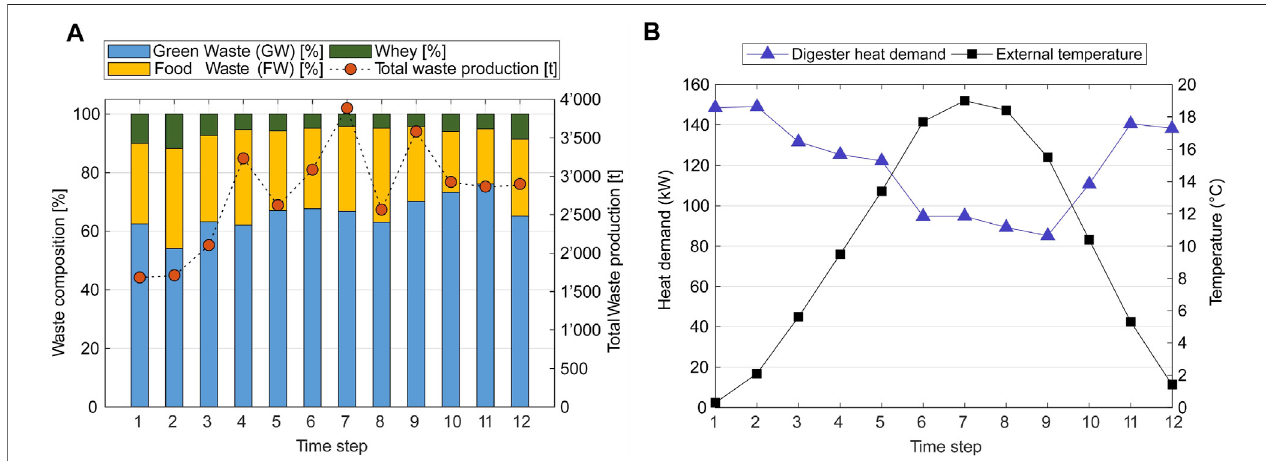
FIGURE 3 | Seasonal effect on: (A) biowaste quantities and composition identi fi ed by total production and sub-biowaste type; (B) external temperature and digester heat demand.